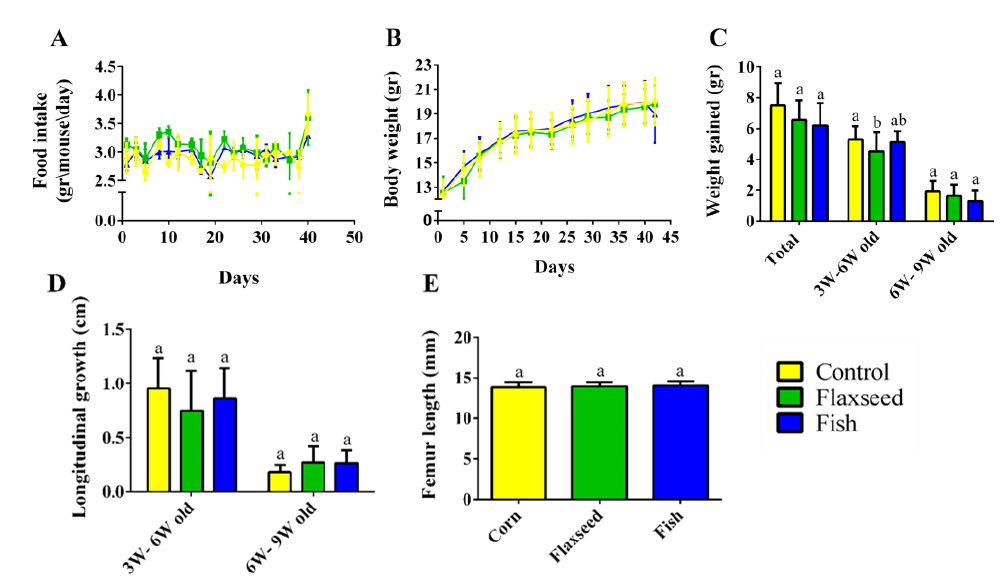
Figure 3. Food consumption and growth patterns. ( A ) Food intake (gr / mouse / day). ( B ) Weight during the entire experiment (gr). ( C ) Growth pattern represented by the total weight gain during two periods: 3–6 weeks of age and 6–9 weeks of age. ( D ) Longitudinal growth of the tail (cm). ( E ) Femur length measured by micro-CT (mm). Values are expressed as means ± SD of n = 8 mice / group; di ff erent superscript letters indicate significant di ff erence ( p < 0.05) which was determined using a one-way ANOVA followed by Tukey’s test.